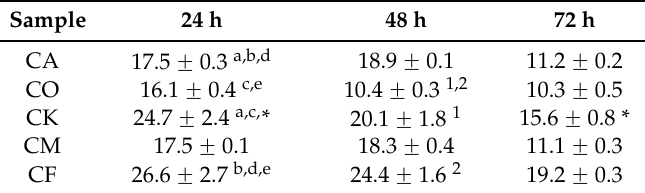
Table 1. Maximal dose (750 µ g ¨ mL ´ 1 ) effect on MCF-7 cells growth inhibition (% of survived cells) induced by leaves water extracts of five Cornus species after treatment for 24, 48 and 72